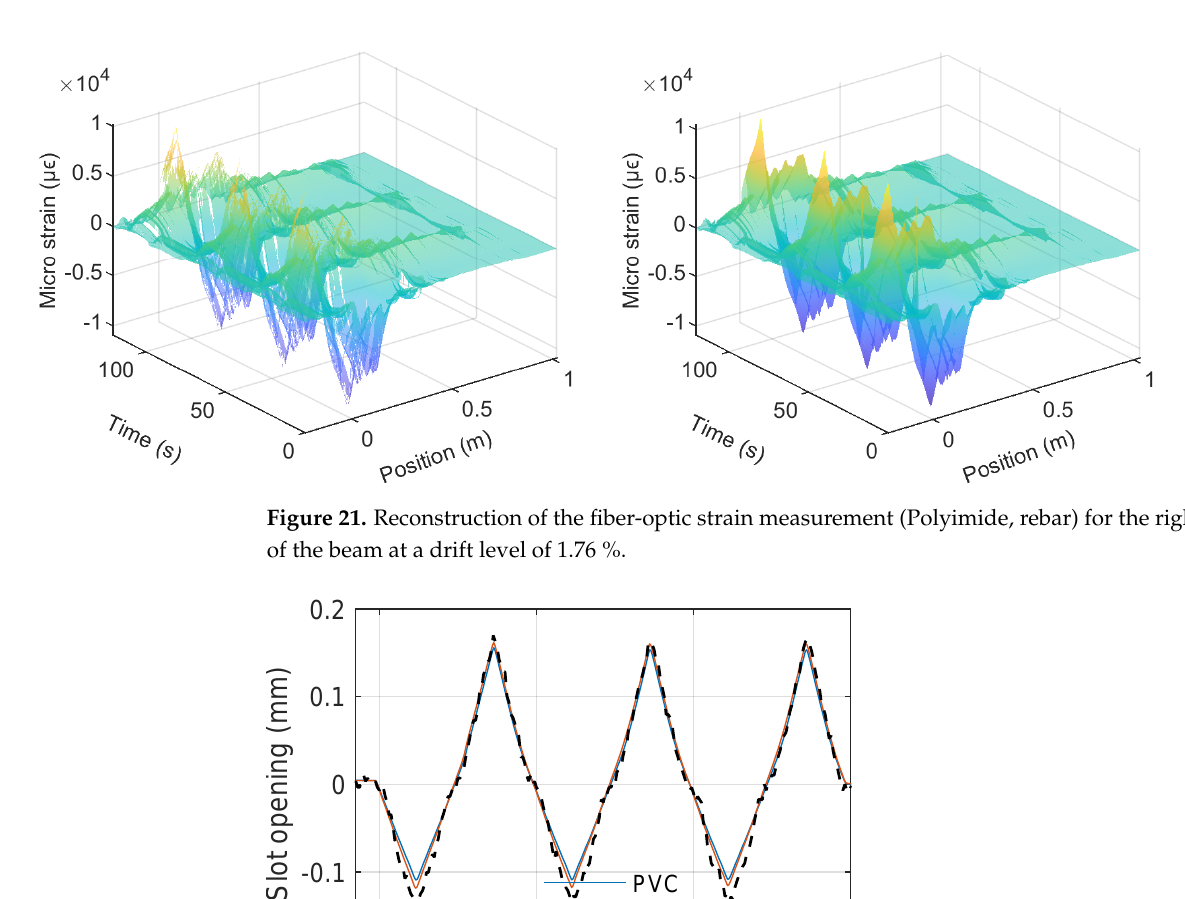
Figure 20. Reconstruction of the fiber-optic strain measurement (Silicon-PFA) for the right side of the beam at a drift level of 1.76%.